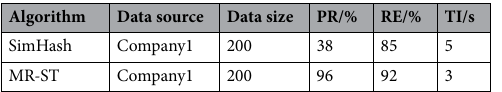
Table 2. Detection results of MR-ST and SimHash algorithm.